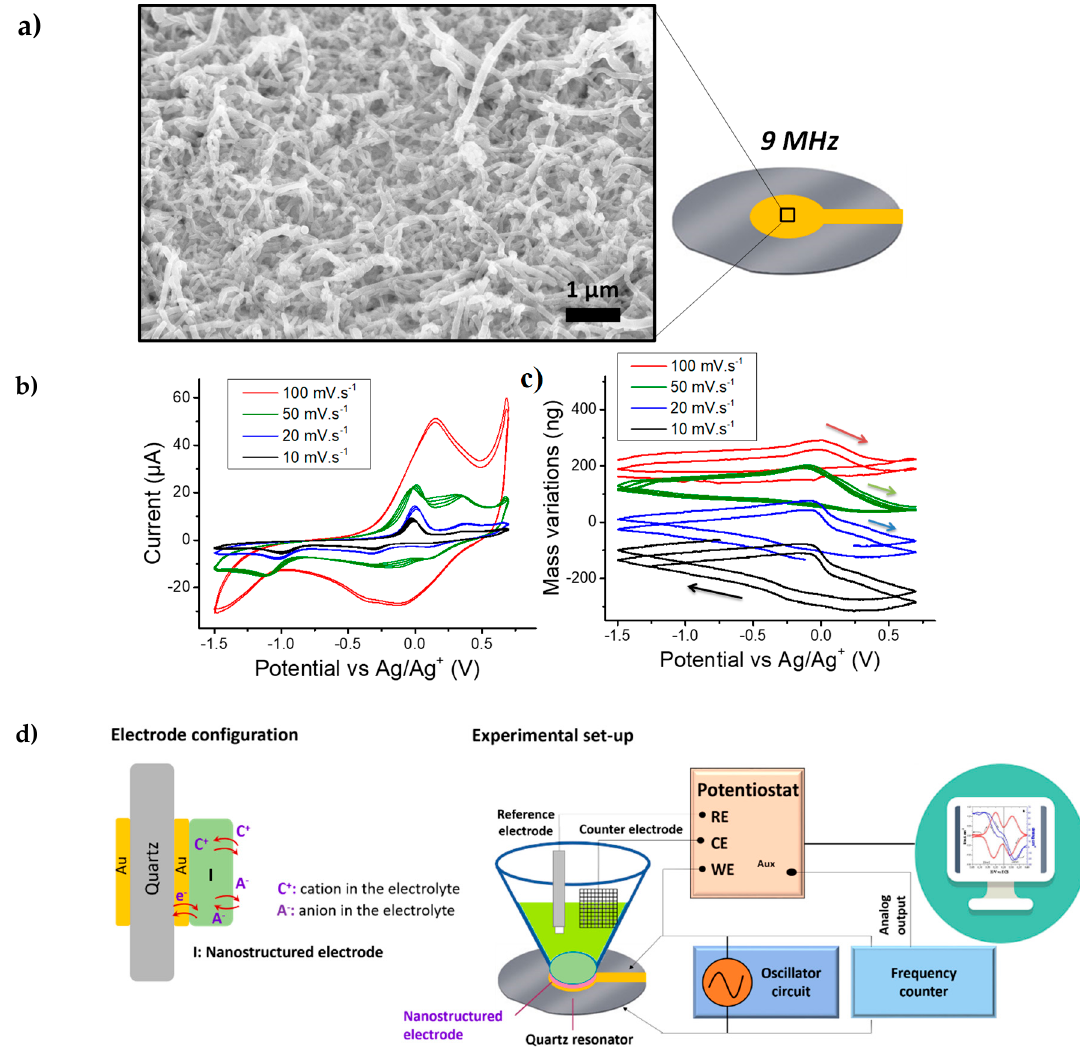
Figure 1. ( a ) SEM micrograph of PEDOT NWs on the surface of a 9 MHz quartz crystal microbalance (QCM); ( b ) cyclic voltammetry (CV) measurements on PEDOT NWs in ACN + 0.5M TBABF 4 at various scan rates, ( c ) the corresponding mass variations obtained with QCM coupling to CV (two cycles) and ( d ) schematic presentation of the quartz configuration and experimental set-up used for electrochemical quartz crystal microbalance (EQCM).